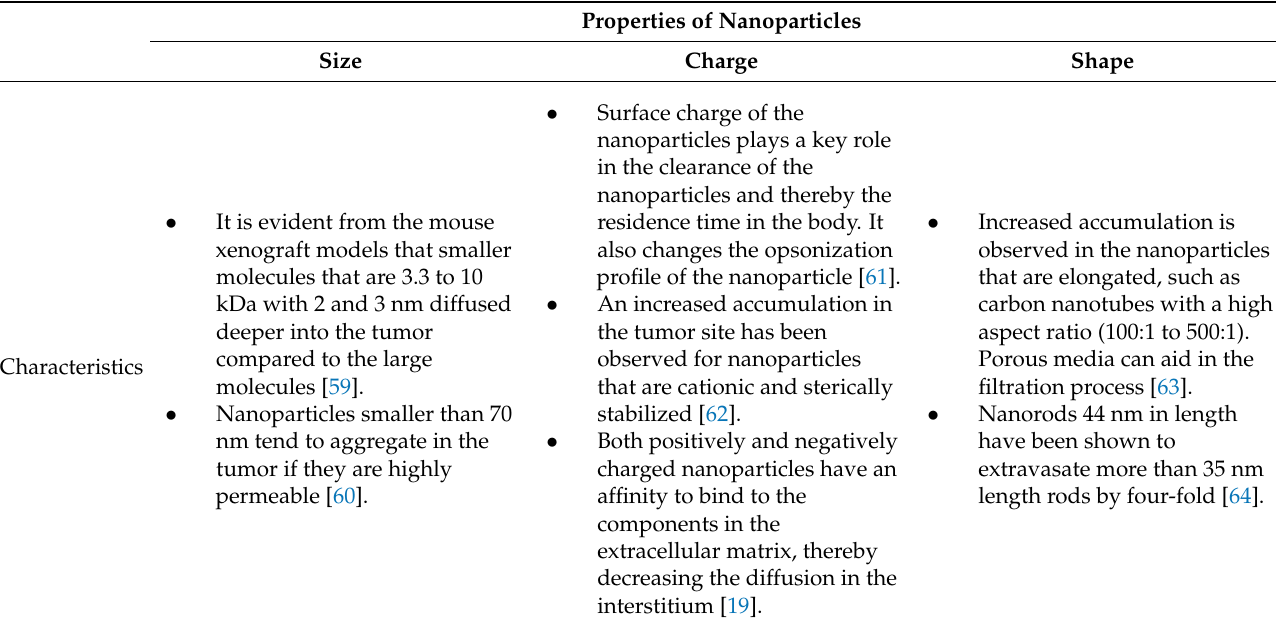
Table 1. Properties of nanoparticles that affect the